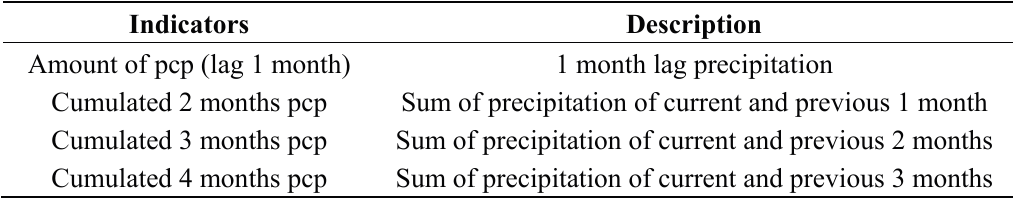
Table 1. Indicators characterizing rainfall variability in the